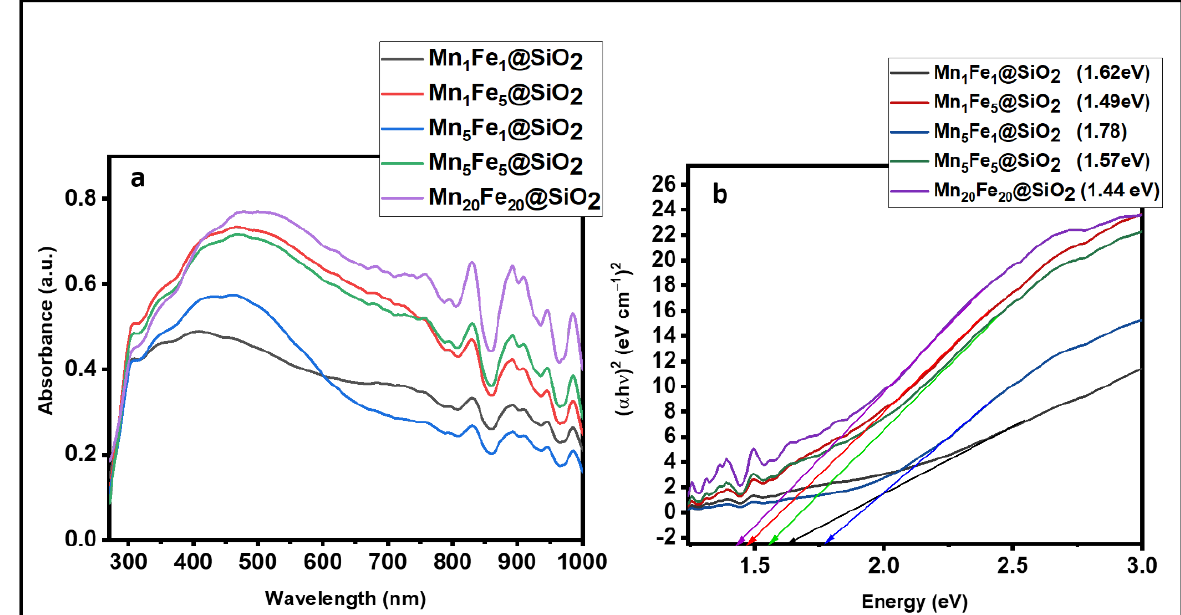
Figure 8. ( a ) UV-Vis DRS spectra; ( b ) bandgap energy.